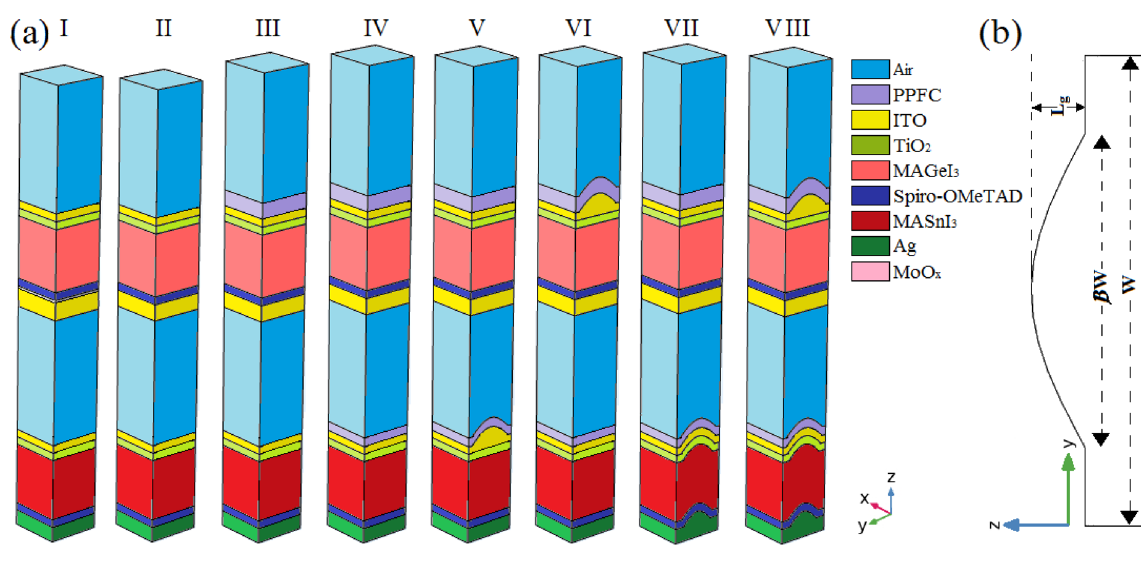
Figure 4. ( a ) 3D schematic of the unit cell of all proposed cases. ( b ) 2D schematic of grating